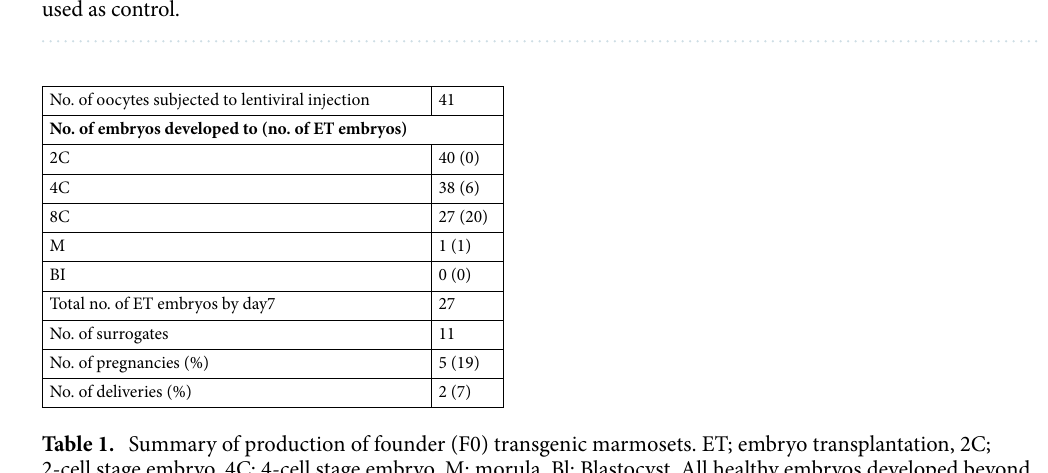
Figure 1. Generation of 0.3k hGPR56 e1m -EGFP transgenic marmosets. ( A ) Schematic diagram of the lentiviral vector. CMV; Cytomegalovirus promoter, ψ; packaging signal, RRE; rev responsive element, cPPT; central polypurine tract, WPRE: Woodchuck hepatitis virus Posttranscriptional Regulatory Element, hGPR56 ; 0.3-kbp human GPR56 e1m cis-element (minimal promoter). ( B ) The transgenic founder infants; I651TgF (female) and I757TgM (male). ( C ) Detection of genomic integration of transgene by genomic PCR. EGFP encoding sequence was amplified using template genomic DNA purified from hair cells of or placentas delivered with infants. Beta-actin amplifications were used as control. ( D ) Detection of transgene expression by RT-PCR. EGFP encoding sequence was amplified from cDNA templates prepared from RNAs purified from hair cells or placentas delivered with them with (RT+) or without (RT−) reverse transcriptase. Beta-actin amplifications were used as control.